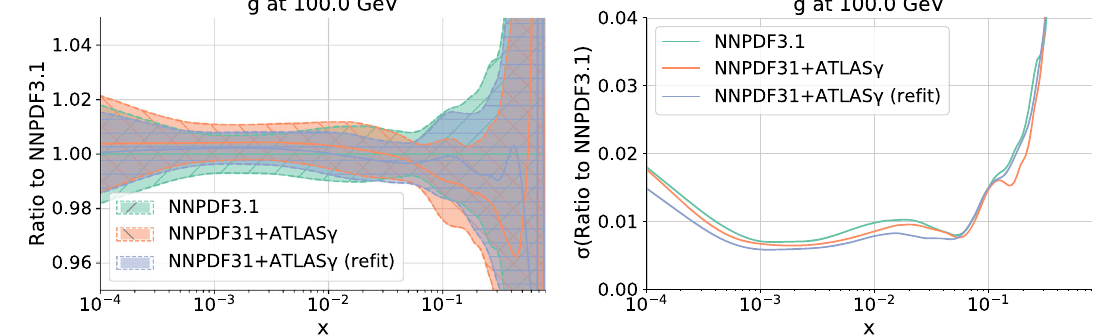
Fig. 13 Same as Fig. 6, now adding to the comparison the results of the fit including the correlations between the experimental systematic uncertainties (labelled as “refit”) Table 10 Same as Table 9, where now the numbers in the second row have been computed using the partial decorrelation model for the exper- imental covariance matrix. See text for more details χ 2 / N dat 1st bin 2nd bin 3rd bin Total